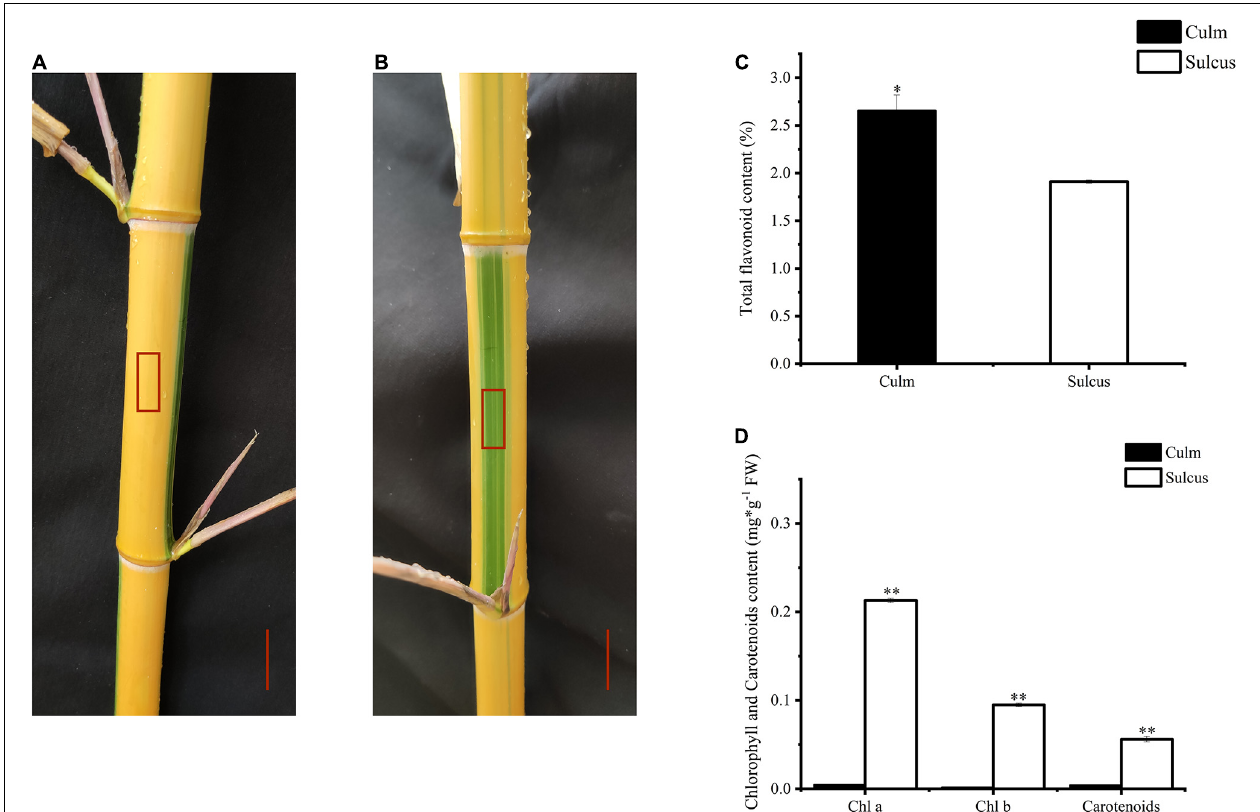
FIGURE 1 | Color phenotype variations in Phyllostachys violascens cv. Viridisulcata. Culm (A) and sulcus (B) in internodes of P. violascens , highlighted as a red rectangle. The red scale was 2 cm. Total flavonoid content (C) and chlorophyll and carotenoid contents (D) in sulcus and culm of P. violasce ns. The significant differences were determined by one-way ANOVA with Duncan post-hoc test (* P < 0.05, ** P <